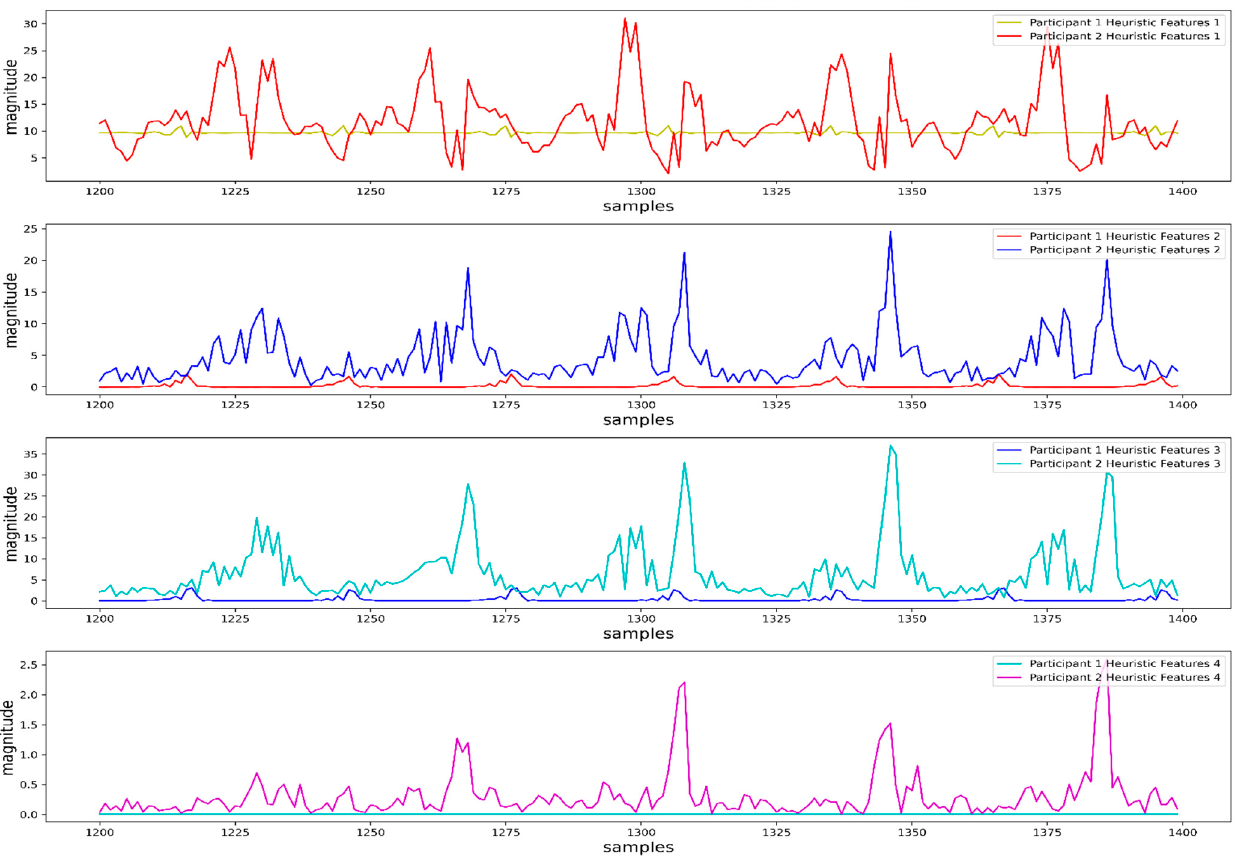
Figure 5. Values of the first four heuristic features for two different activities from two different participants. Participant 1 performed activity lying, and participant 2 performed activity running at 5 METs.